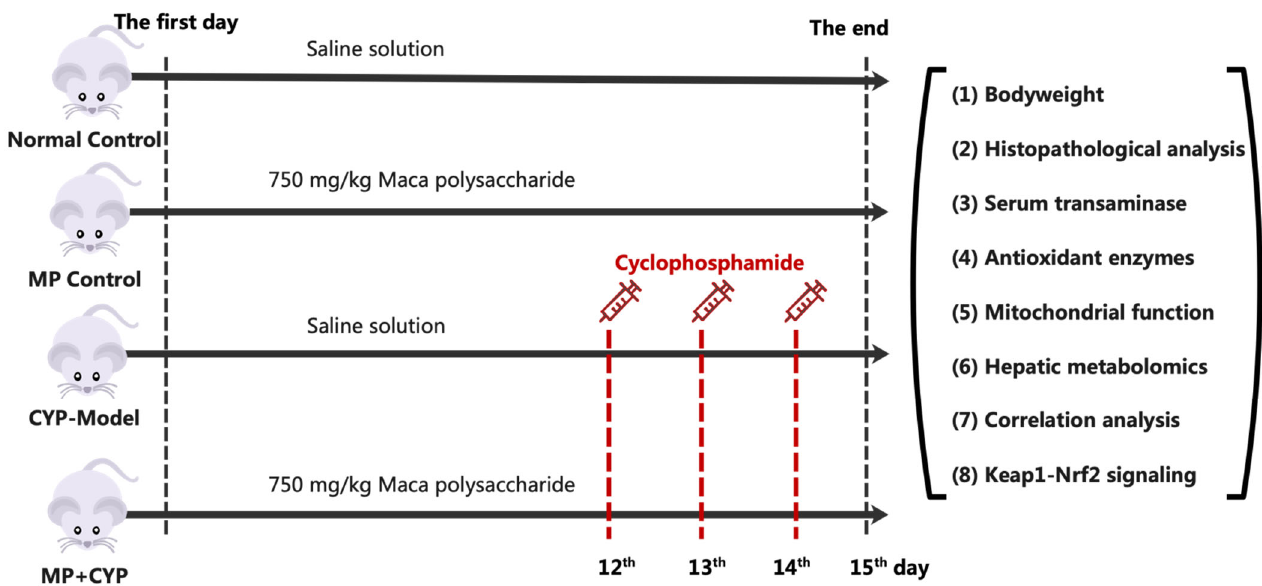
Figure 1. Workflow of the experiment procedure. (1)–(5) were performed for each group; (6)–(8) were performed for NC, CYP Model, and MP+CYP group liver tissues.